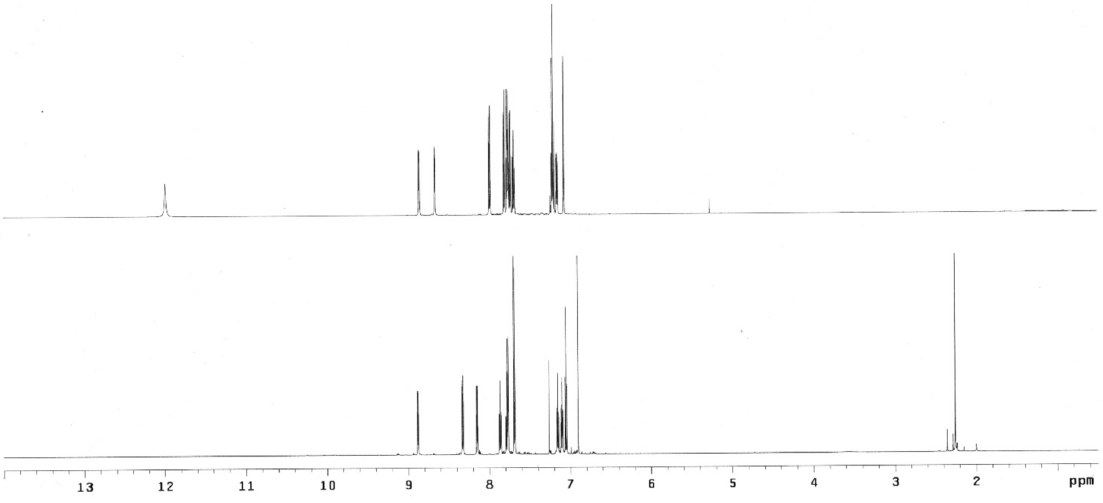
Figure 1. 1 H NMR spectra for L 3 H (upper) and [L 3 ]Pd(OAc).